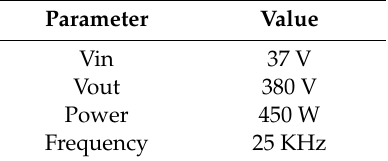
Table 1. Experimental parameters.